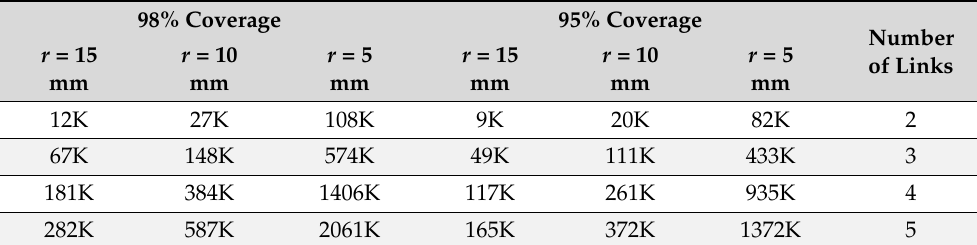
Figure 6. Areal coverage simulation example results for 95% coverage with two cover radii. The top figures present areal coverages of the 5R MASR workspace, produced from 10 5 cloud points, with cover radii of 10 mm ( left ) and 5 mm ( right ). The bottom figures show differences in the convergence of the coverage percentage as the number of active joints decrease and the cover radius increases. Table 2. Criteria for the number of cloud points to generate to achieve 95% and 98% area coverage for a cover radius of 5, 10, and 15